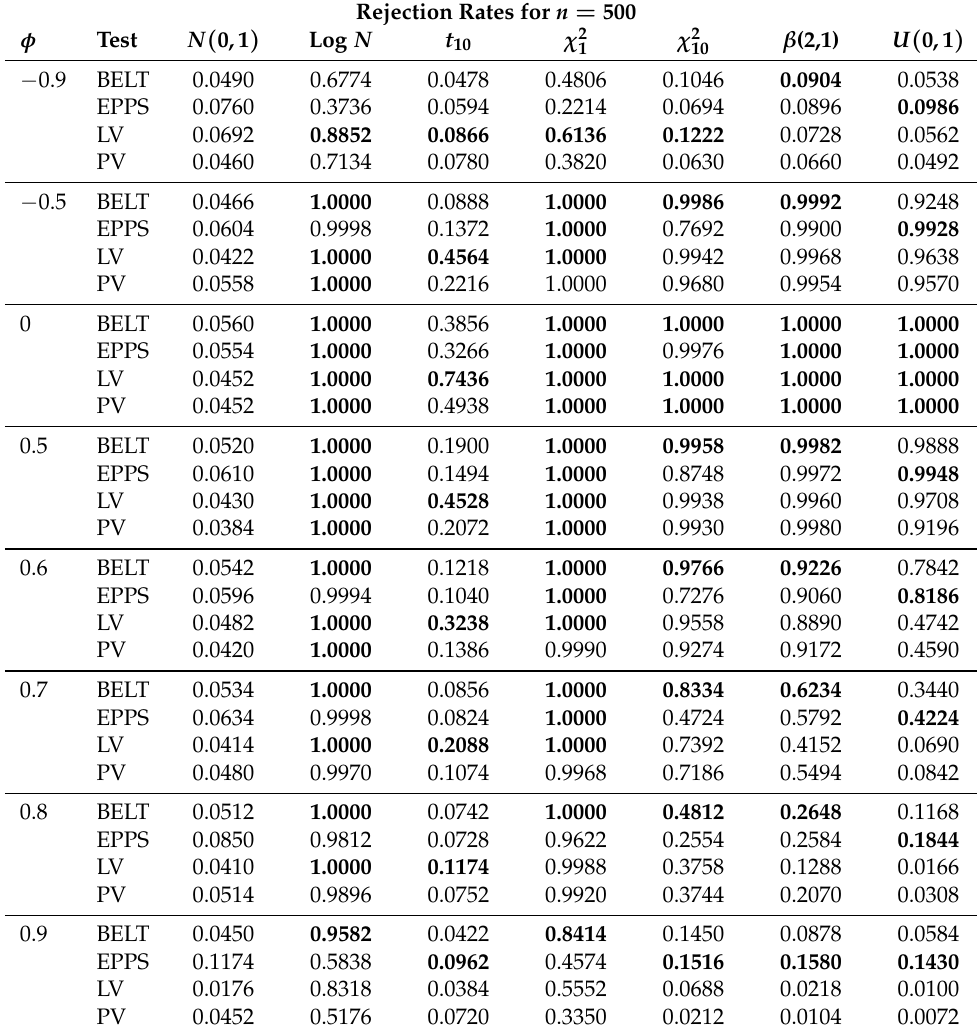
Table 5. Empirical rejection probabilities of the process defined in (10) at the 0.05 nominal level for n = 500 using 5000